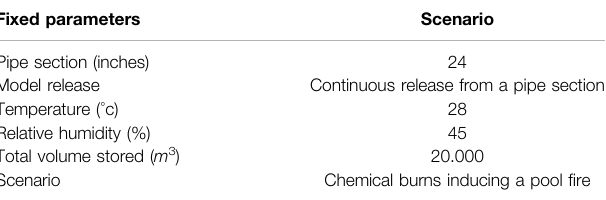
TABLE 8 | Parameters for the scenario simulation. Fixed parameters